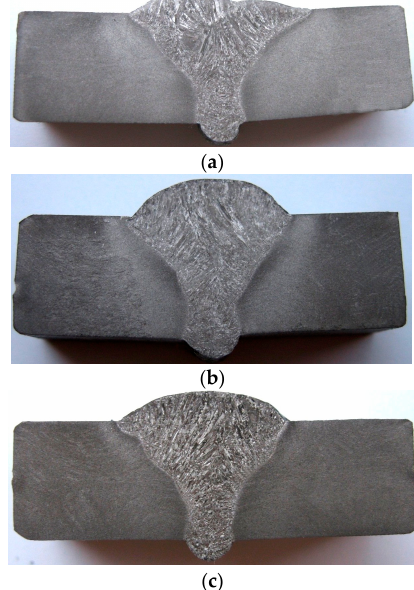
Figure 3. Macroscopic images of the welded joints cross section: ( a ) E l welded joint = 6.9 kJ/cm, E l filling layers = 10 kJ/cm; ( b ) E l welded joint = 6.9 kJ/cm, E l filling layers = 15 kJ/cm; and ( c ) E l welded joint = 6.9 kJ/cm, E l filling layers = 20.7 kJ/cm. Chemical reactive: ferric chloride 10 cm 3 ; hydrochloric acid 30 cm 3 ; and ethylic alcohol 120 cm 3 .